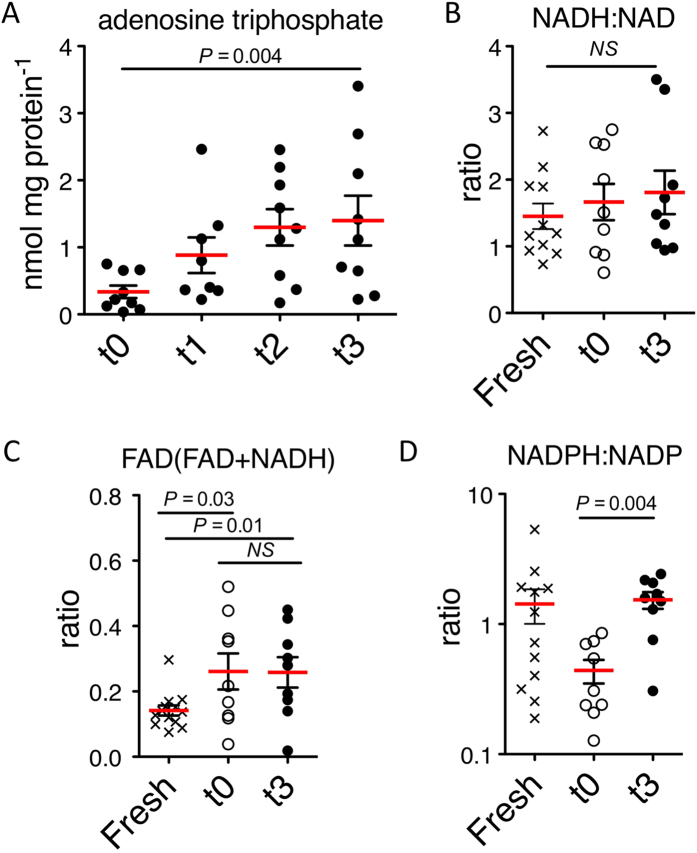
Analysis of adenosine and redox cofactors in human liver tissue.(A) ATP concentration in biopsies from SNMP- preserved liver grafts. Absolute ATP content increased significantly during SNMP preservation (n = 9, P = 0.03) (B) NADH:NAD ratios in human liver biopsies before (n = 9) and after (n = 9) SNMP compared to fresh samples (n = 12). The ratio NADH:NAD was unchanged during SNMP (n = 9) and did not significantly differ from fresh samples (n = 12) at either time point (P ≥ 0.05) (C) Estimated FAD were increased after ischemia, relative to fresh samples (P = 0.03) and remained unchanged during perfusion (n = 9, P ≥ 0.05) (D) NADPH:NADP ratios increased significantly during SNMP (n = 9), and were restored to fresh liver levels (n = 12; P = 0.0012). Bars represent mean ± sem.